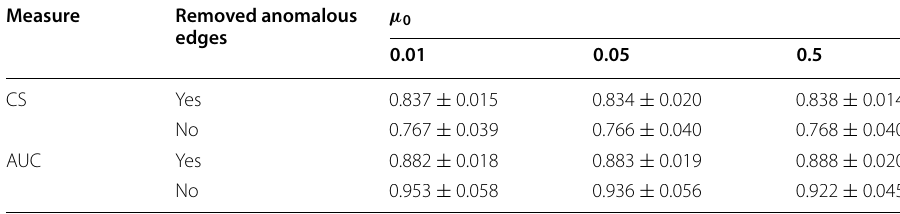
We present the ability of ACD in community detection, represented by cosine similarity (CS). Moreover, we validate the model by measuring the AUC in link prediction tasks. The results are robust with respect to the initial values of µ . By removing the edges detected as anomalies, the community detection task is improved. Here, π = 10 − 3 . The CS errors are calculated by averaging over 20 runs of the edge removal routine. To estimate AUC we perform 5-fold cross validation and report the averages and standard deviations over the